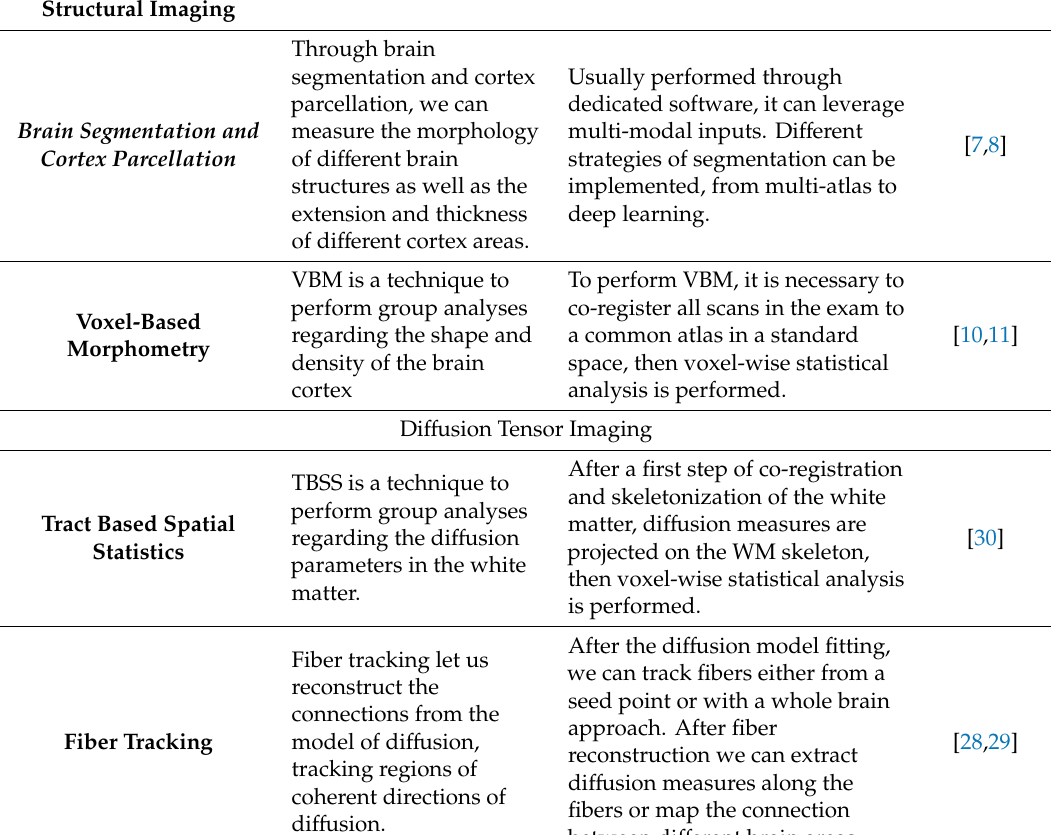
Table 1. Summary of main MRI techniques and their application to cerebrovascular diseases. In the left column, there is a brief description of the potential application of the imaging technique; in the right column, there is a brief description of the